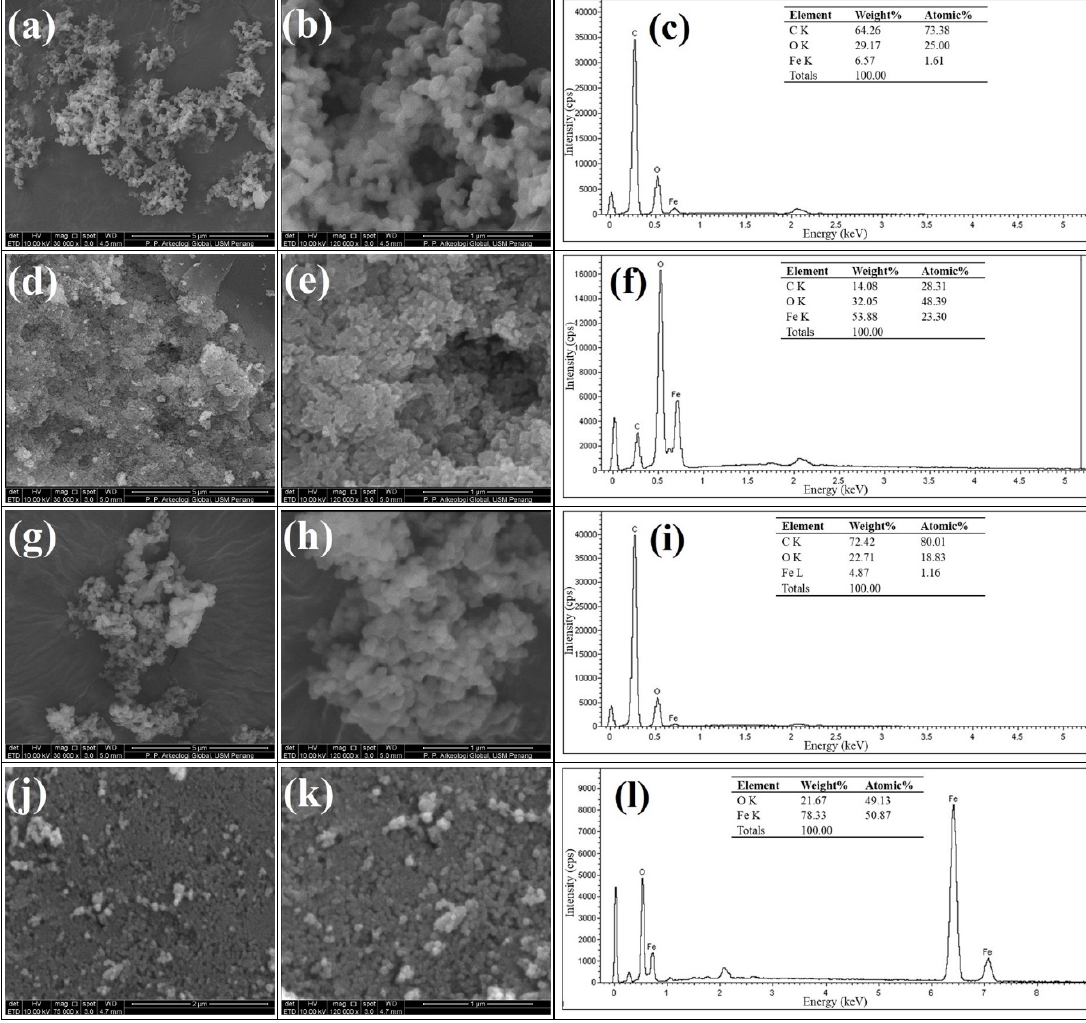
Figure 4. SEM images with different resolutions (30 k × , 120 k × ) and EDX elemental composition of Fe 3 O 4 @C-T 190 t 3 ( a – c ), Fe 3 O 4 @C-T 190 t 4 ( d – f ), Fe 3 O 4 @C-T 190 t 5 ( g – i ), and Fe 3 O 4 NPs ( j – l ), respectively.